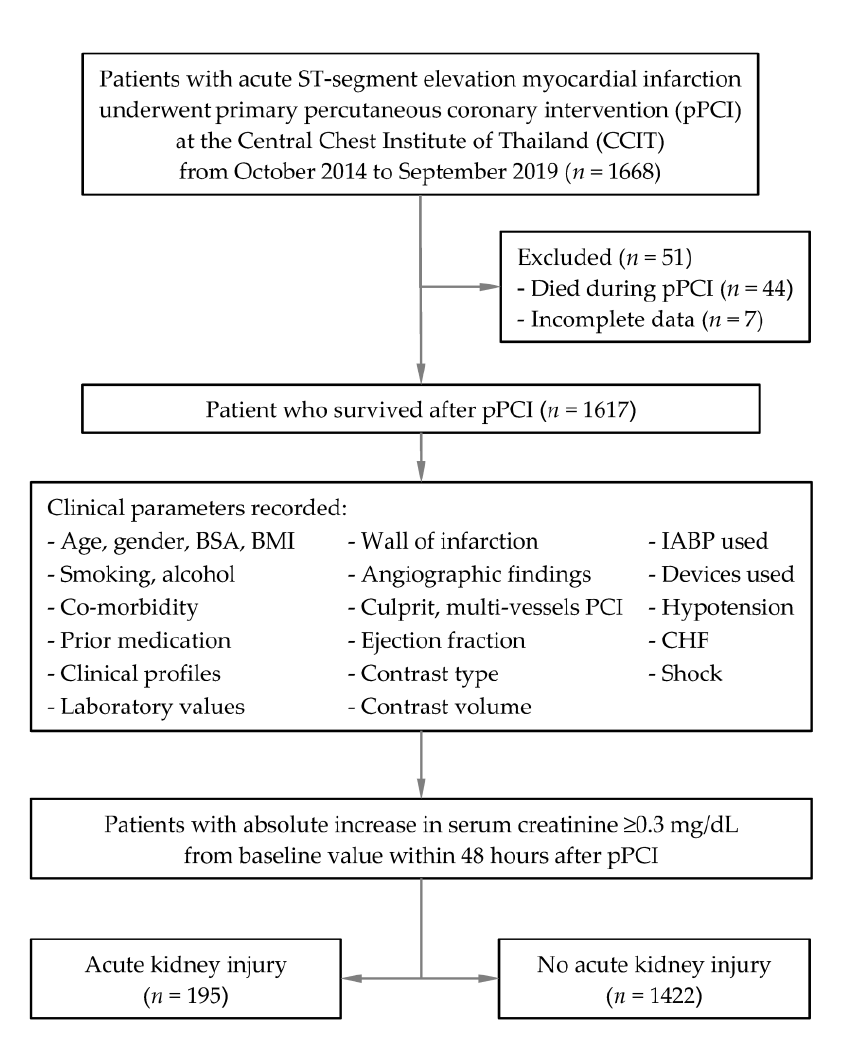
Figure 1. Flow diagram of patient details. Abbreviations: pPCI, primary percutaneous coronary intervention; CCIT, Central Chest Institute of Thailand; BSA, body surface area; BMI, body mass index; IABP, intra-aortic balloon pump; CHF, congestive heart failure. Table 1. Baseline characteristics, pathology, pathophysiology, procedure, findings, and complication in patients with or without AKI.